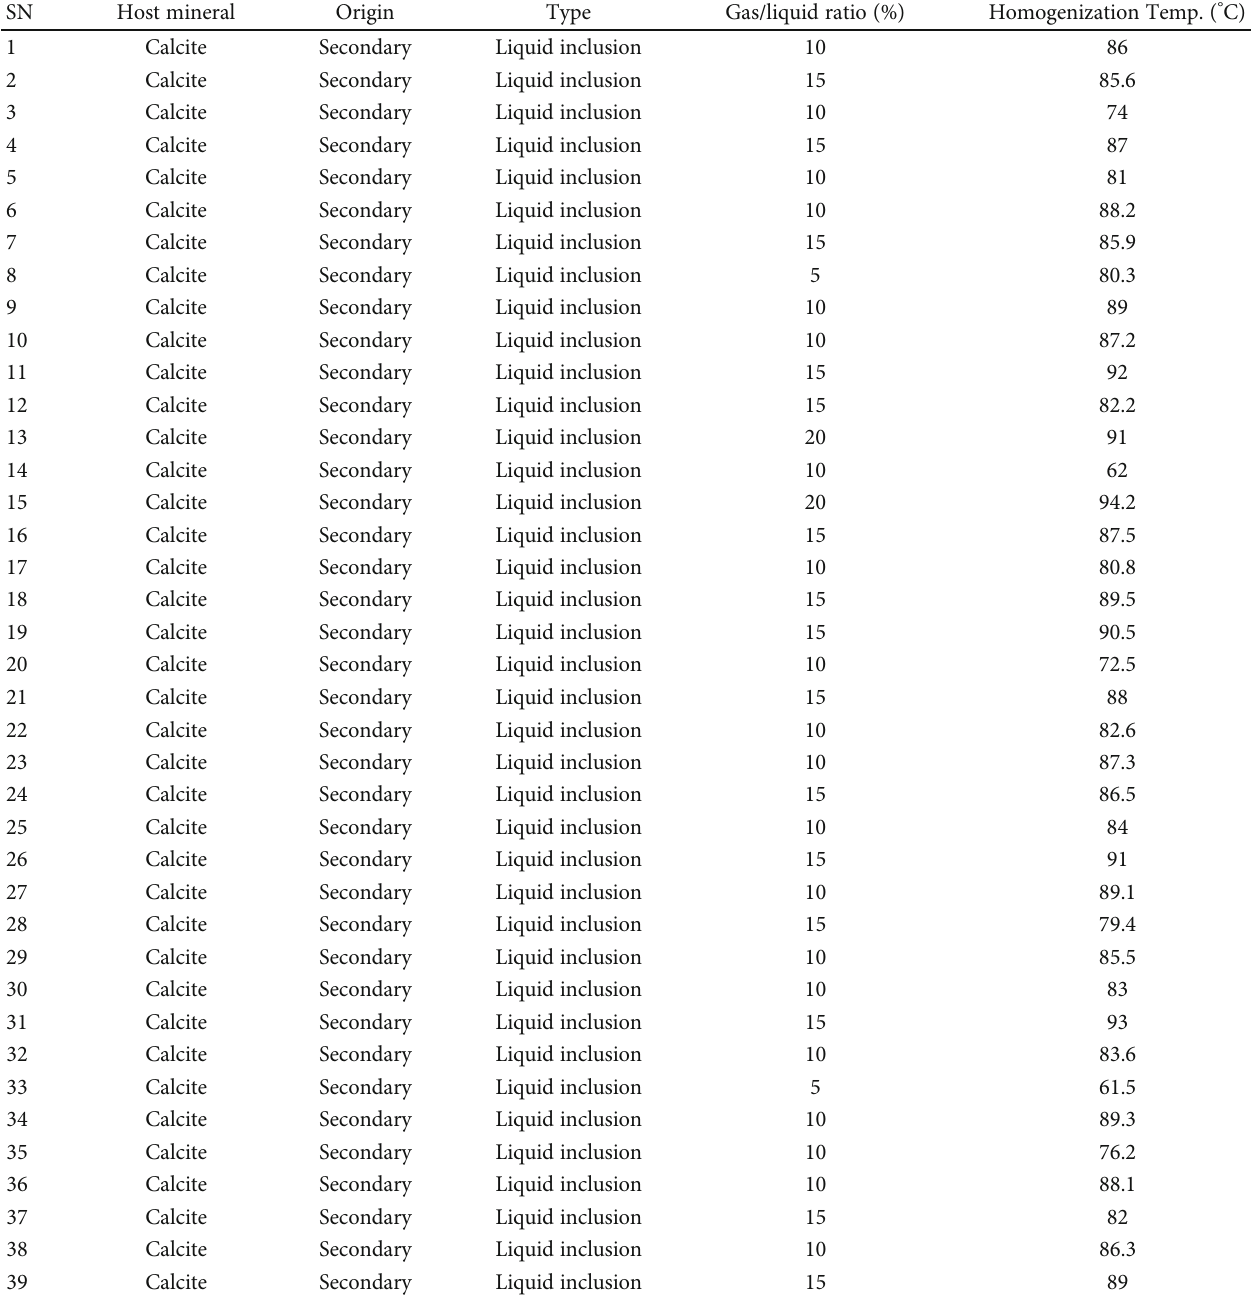
Table 4: Fluid inclusion parameter table of bedding fracture fi llers in Lucaogou